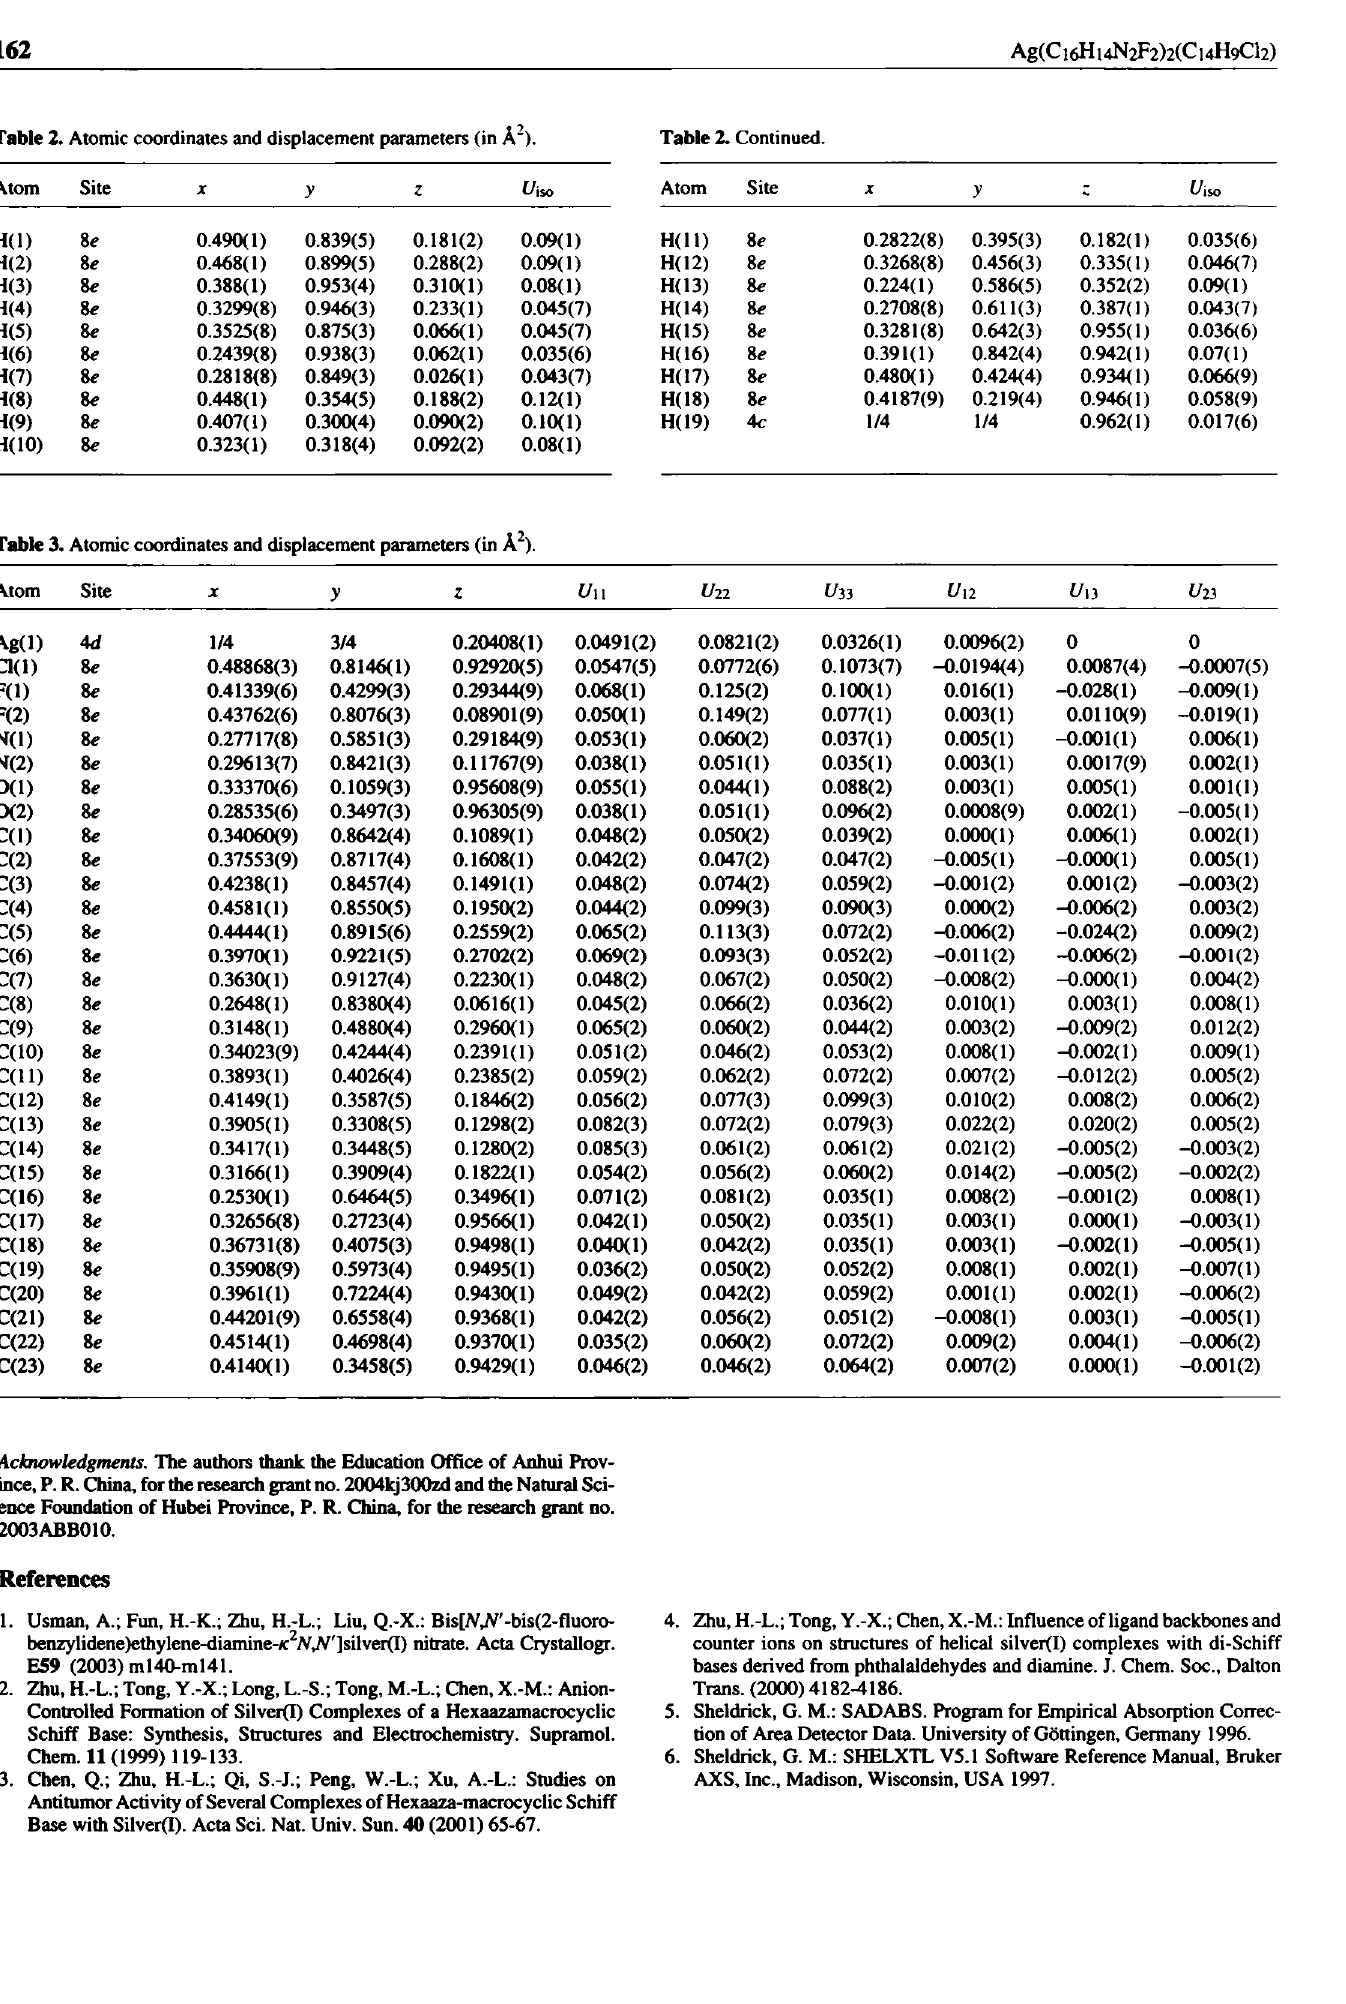
Table 2. Atomic coordinates and displacement parameters (in Â 2 ). Table 2. Continued.